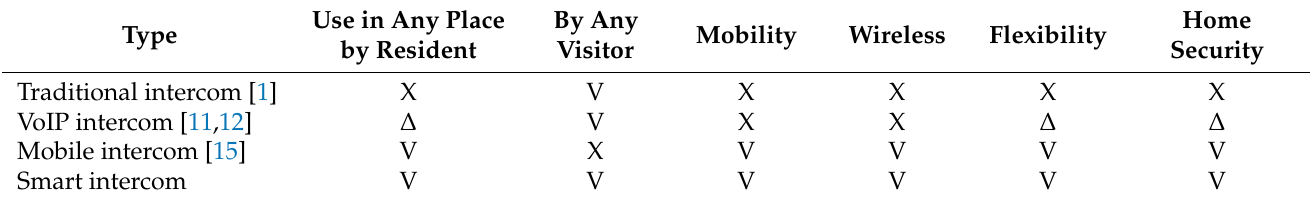
Table 5. Intercom advantages and disadvantages comparison